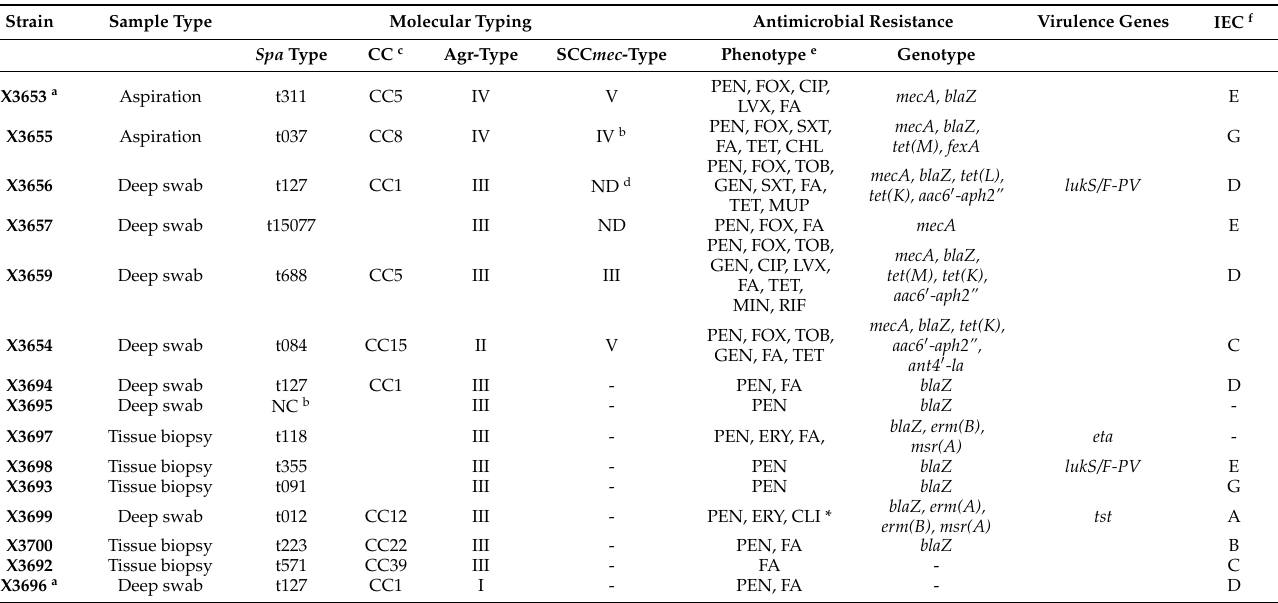
Table 3. Characteristics of the six MRSA and nine MSSA isolates recovered from diabetic foot infections in this